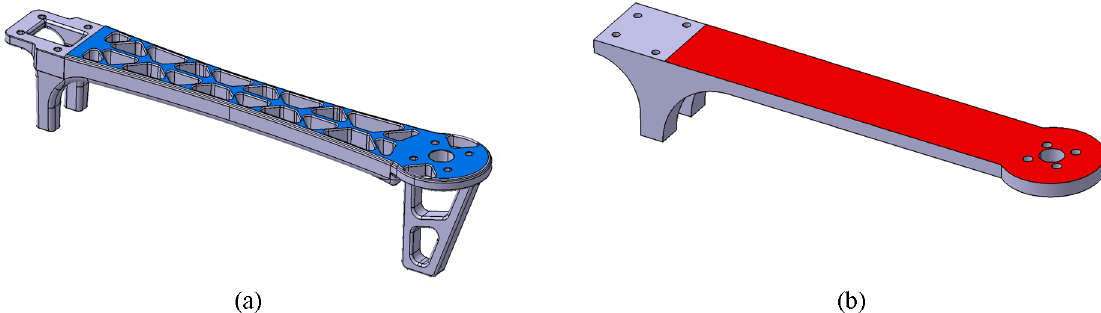
Fig. 2. (a) Initial arm: 218mm in total length, variable width 24 – 31 mm (blue area: approximatively 15 cm 2 on each side). (b) Revised arm: 218 mm in total length, 31 mm width (red area: 45 cm 2 on each side).